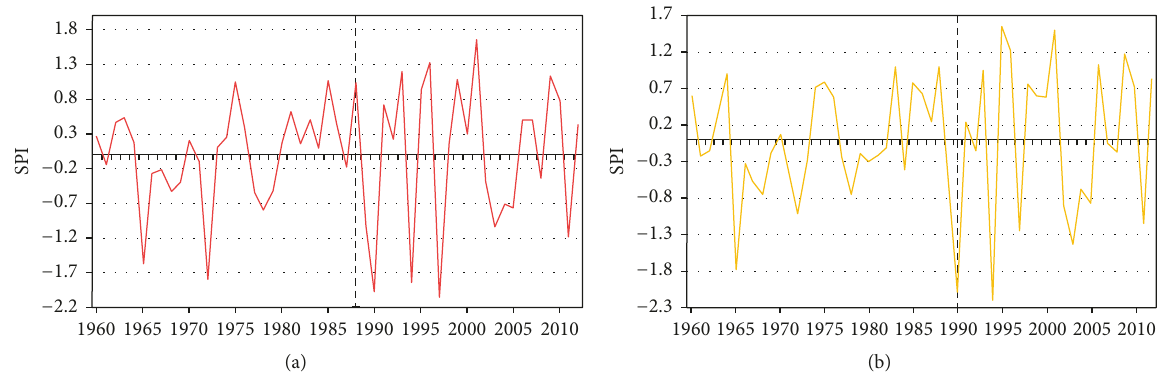
Figure 5: Temporal manifestation of SPI with results of the SRSD superimposed to show the shift in the variance (dashed line) for (a) Cluster 1 and (b) Cluster 2 during the OND subseason. The data is from 1960 to 2013.